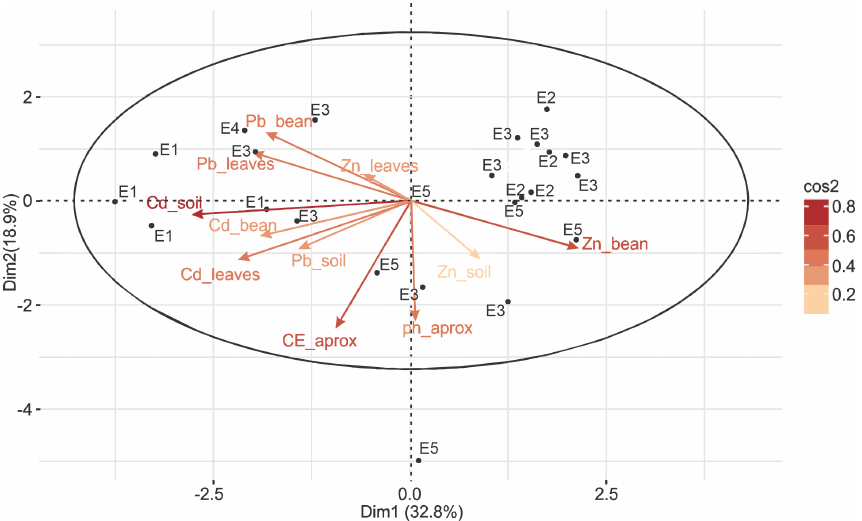
Figure 6. Biplot for Principal Component Analysis for heavy metals relating to sample units by sectors and quality of representation of variables with principal